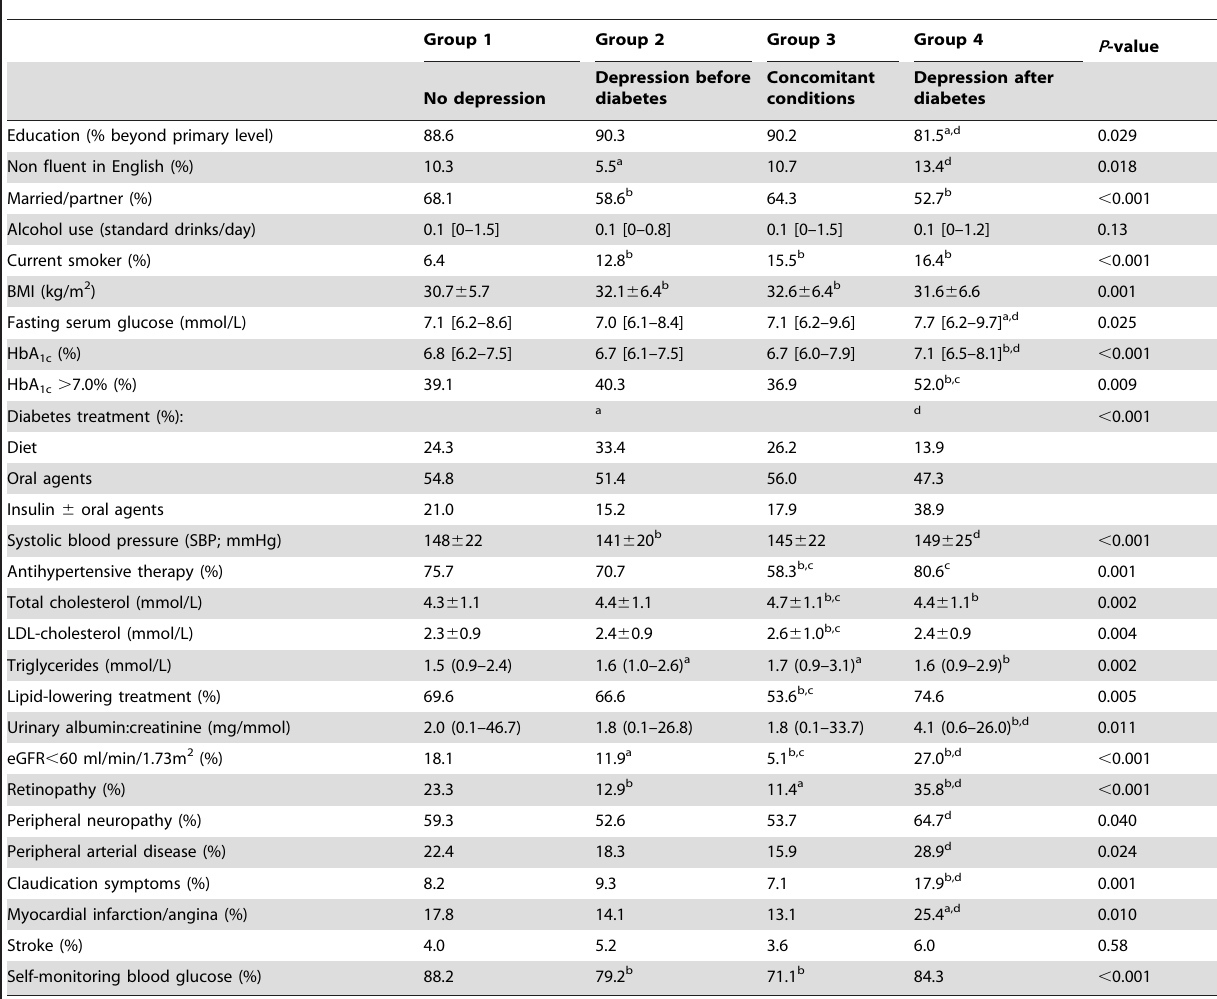
Table 2. Demographic and clinical characteristics of the sample by lifetime depression